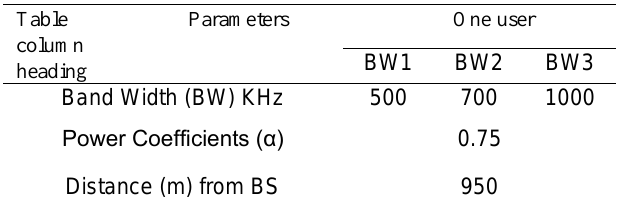
Table 3. Parameters utilized for the third